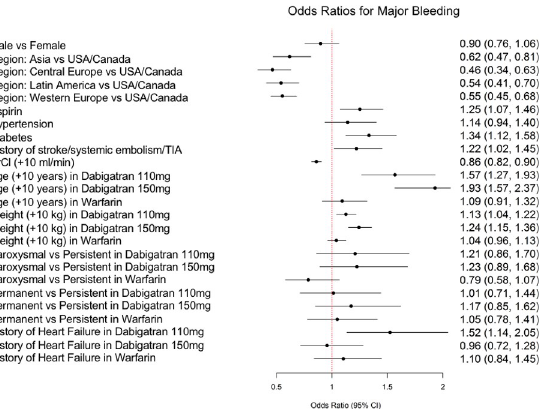
Fig 2. Risk prediction model for major bleeding. Shown are the odds ratio (OR) and 95% confidence interval (CI) for each variable. For variables with interactions with treatment assignment, ORs are presented separately for treatment with dabigatran 110mg, dabigatran 150mg, and warfarin. CI, confidence interval; CrCl, creatinine clearance; TIA, transient ischemic attack; USA, United States of America.